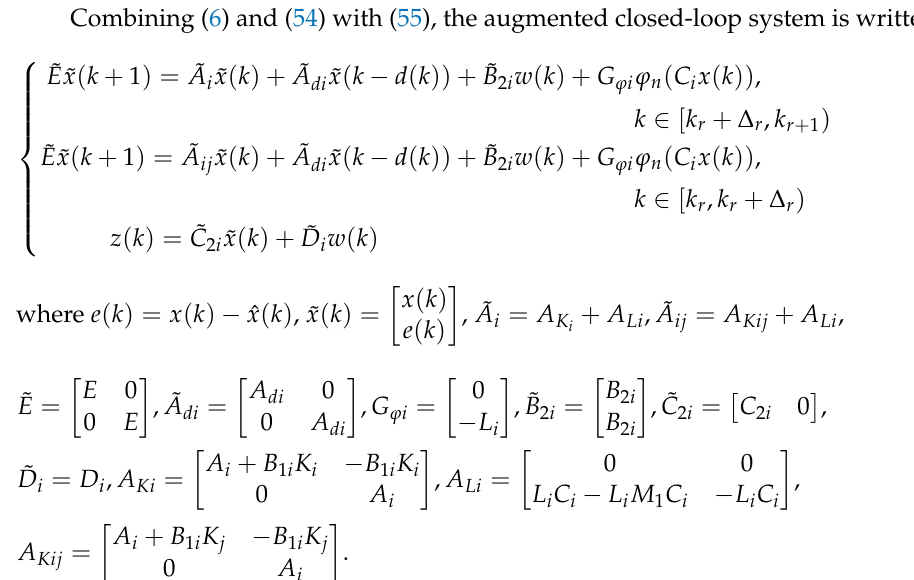
Figure 1. Diagram of asynchronous